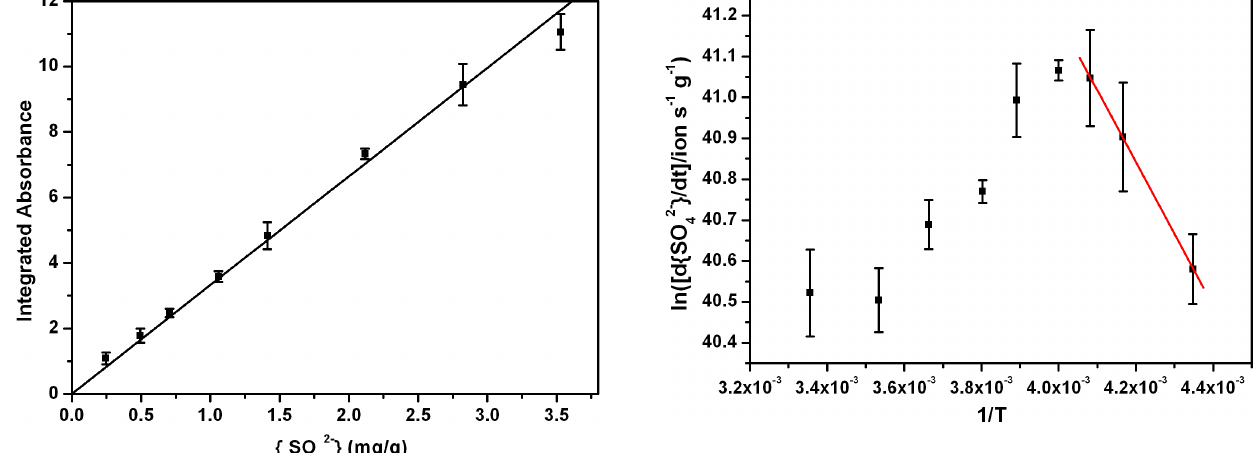
Fig. 5. The relationship between formation rate of sulfate and tem- perature. The red solid line is the linear regression of the rate of sul- } / dt with the reciprocal value of temperature fate formation d { SO 2 − 4 (1/ T ) at temperatures below 250K. The slope is − 1759.24 ± 23.58 ( σ)